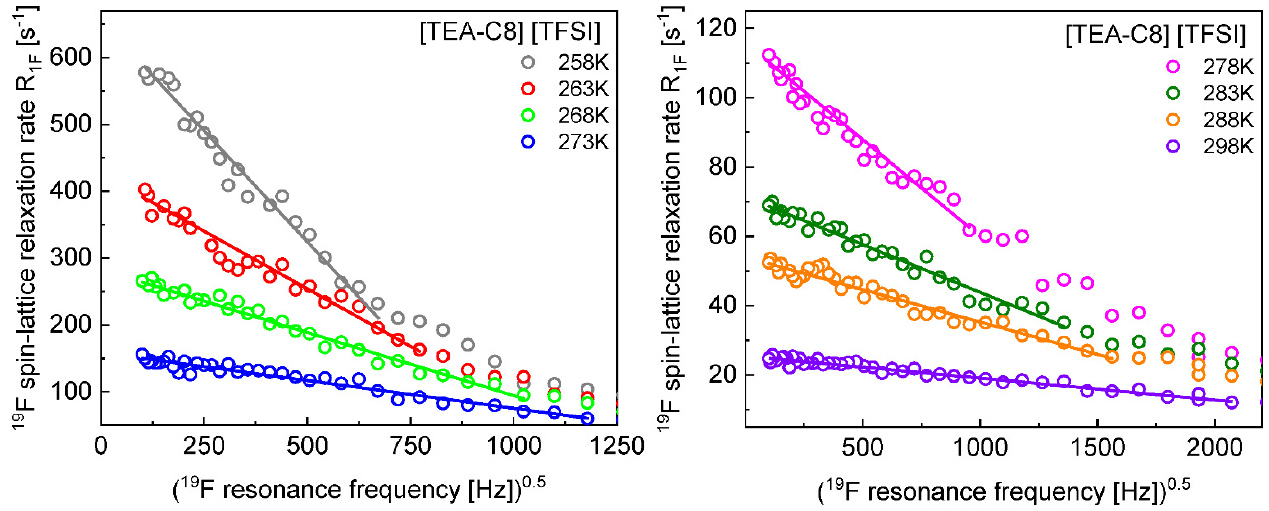
Figure A1. 19 F spin-lattice relaxation data for [TEA − C8] [TFSI] versus the squared root of the resonance frequency; solid lines represent linear fits in the low frequency range.